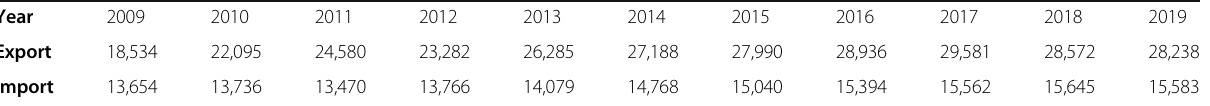
Table 2 Number of links Port-Country in the bipartite networks, for import and export flows in period 2009 – 2019